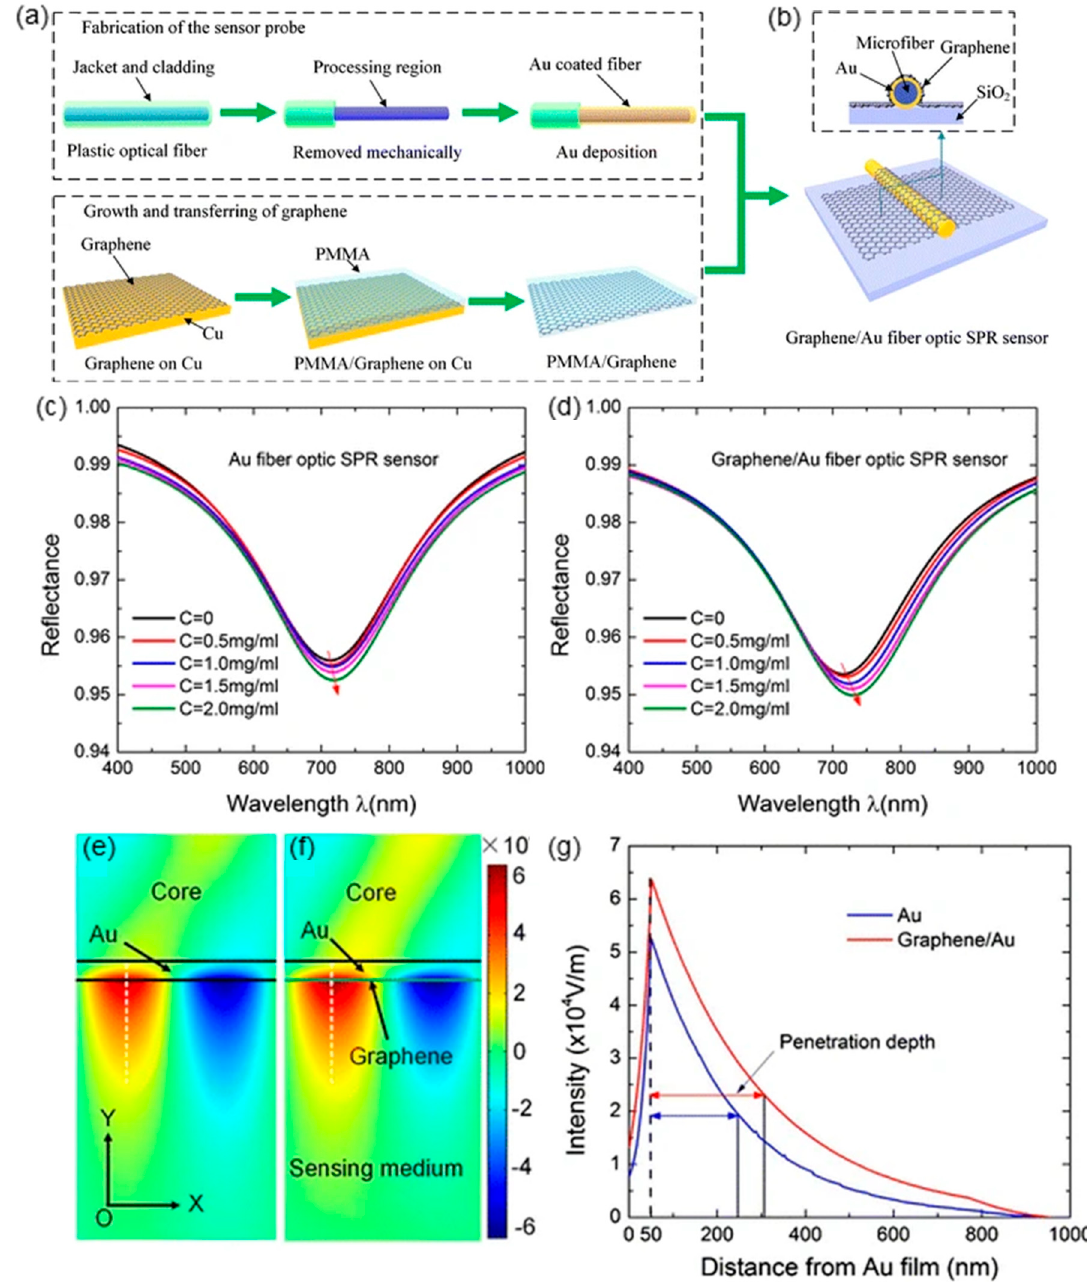
Figure 6. ( a ) Fabrication of Au coated fiber and preparation of graphene monolayer. ( b ) The schematic illustration of cross-section view of the proposed graphene / Au fiber-optic SPR sensor. ( c ) Reflection spectra of Au ( c ) and graphene / Au ( d ) fiber-optic SPR sensor with varying bovine serum albumin (BSA) concentration. ( e ) Finite element analysis (FEA) simulation of electric field distribution of fiber-optic SPR sensors with ( e ) and without ( f ) graphene. ( g ) Electric field decaying along Y-direction (Figure adapted with permission from reference [6]).